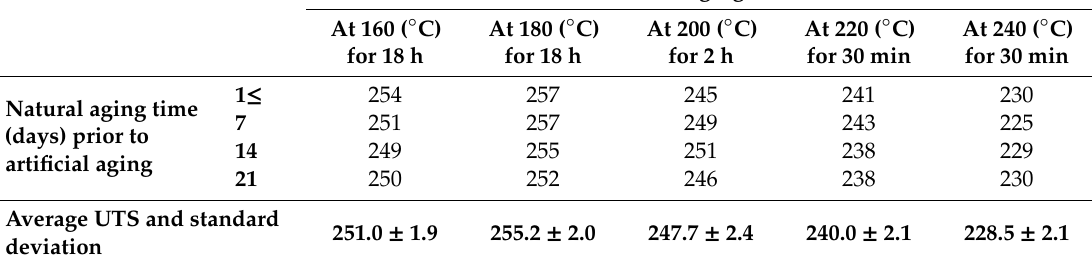
Table 2. Tensile strength of the welded samples subjected to natural aging for less than one day to 21 days prior to artificial aging process conducted at di ff erent conditions based on the obtained results in the previous part of the